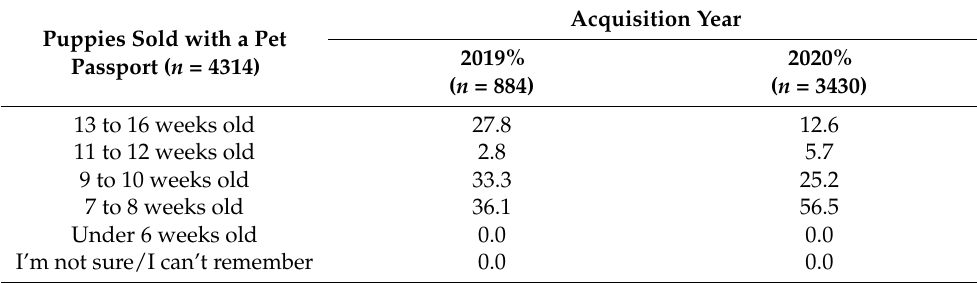
Table 3. Age when taken home for 2019 puppies ( n = 884) and Pandemic Puppies ( n = 3430) sold under 16 weeks with a Pet